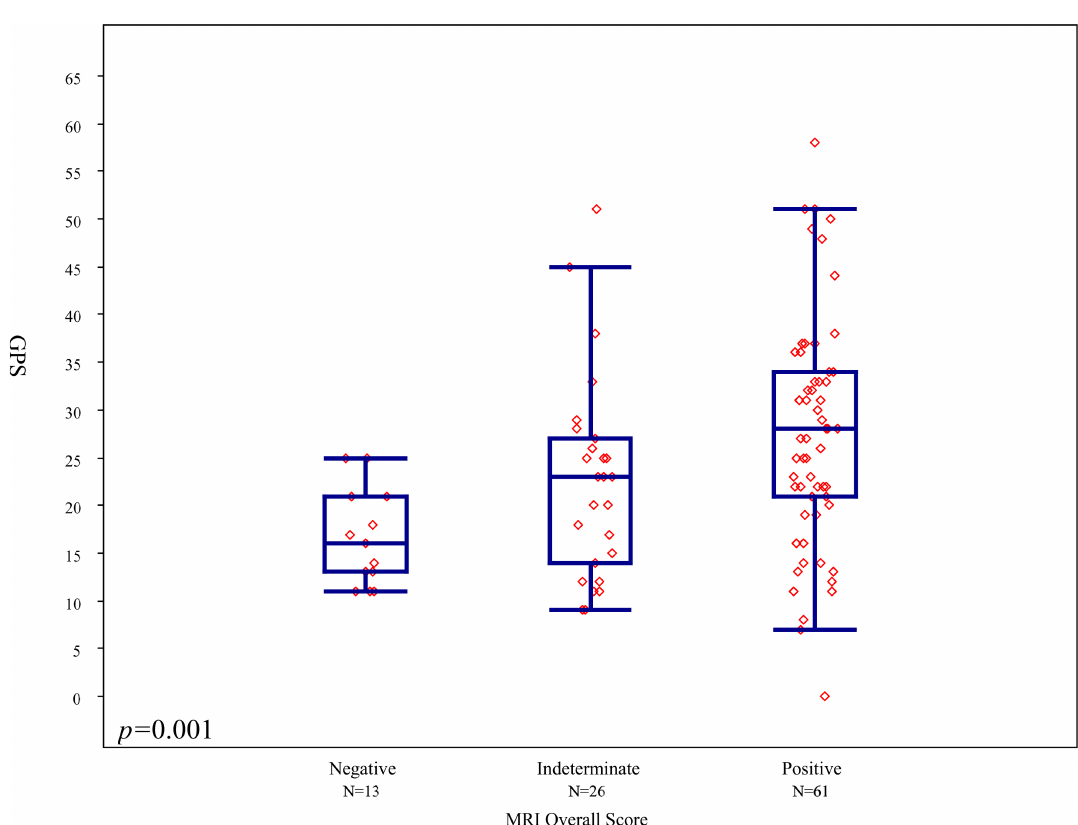
Fig 1. Distribution of GPS scores by MRI findings among all 100 patients.